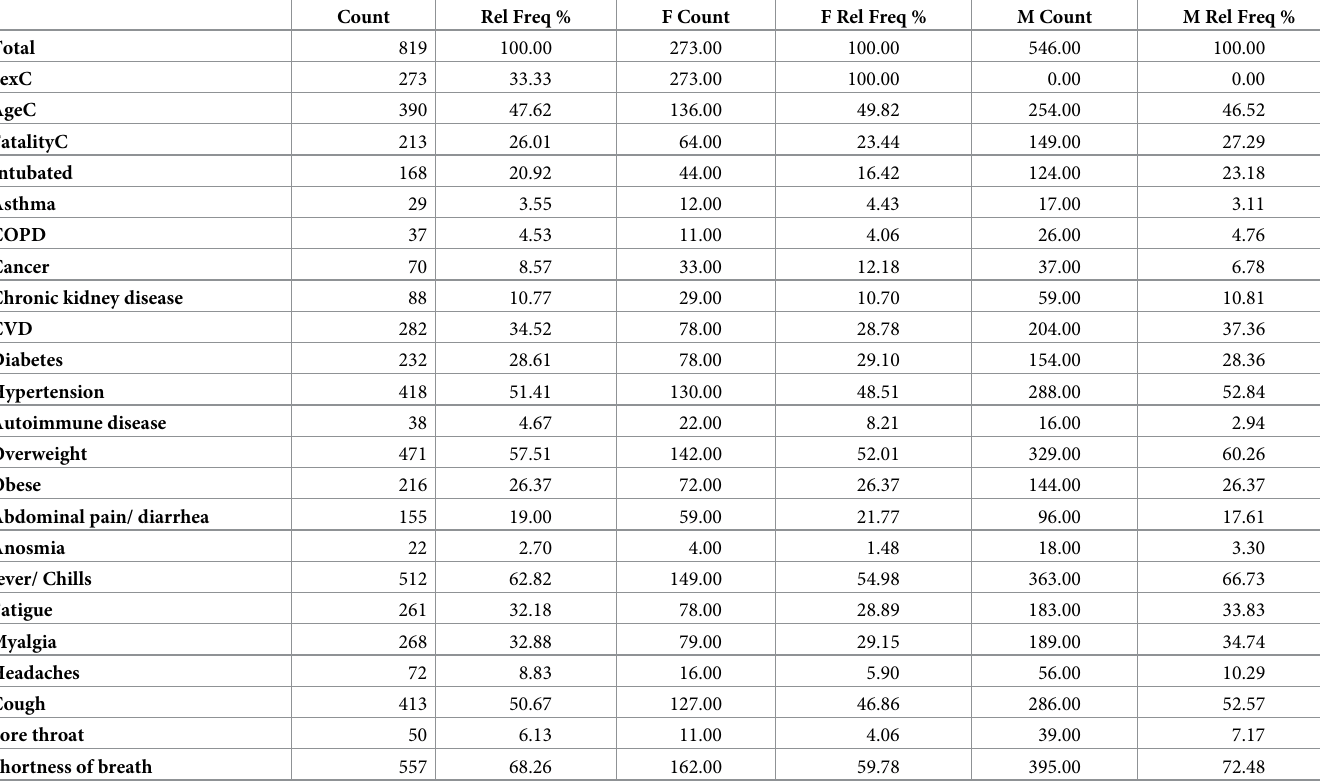
Table 2. Descriptive statistics of the COVID-19 population stratified by medical